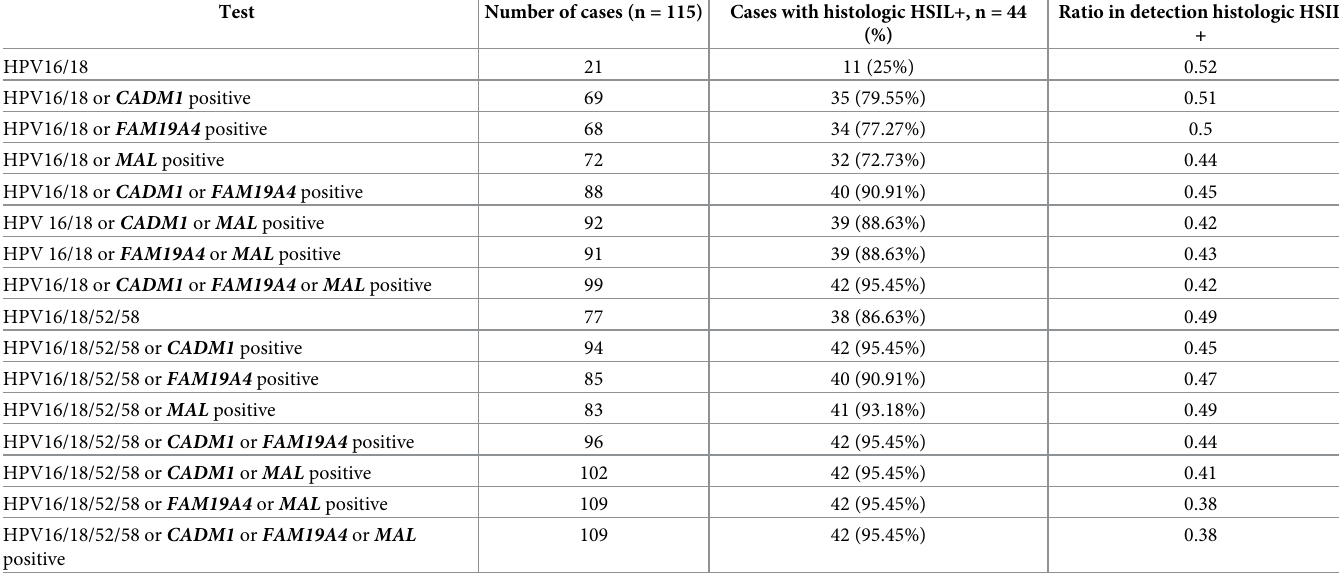
Table 7. Combining methylation markers to HPV genotyping in detecting histologic HSIL+ lesions.